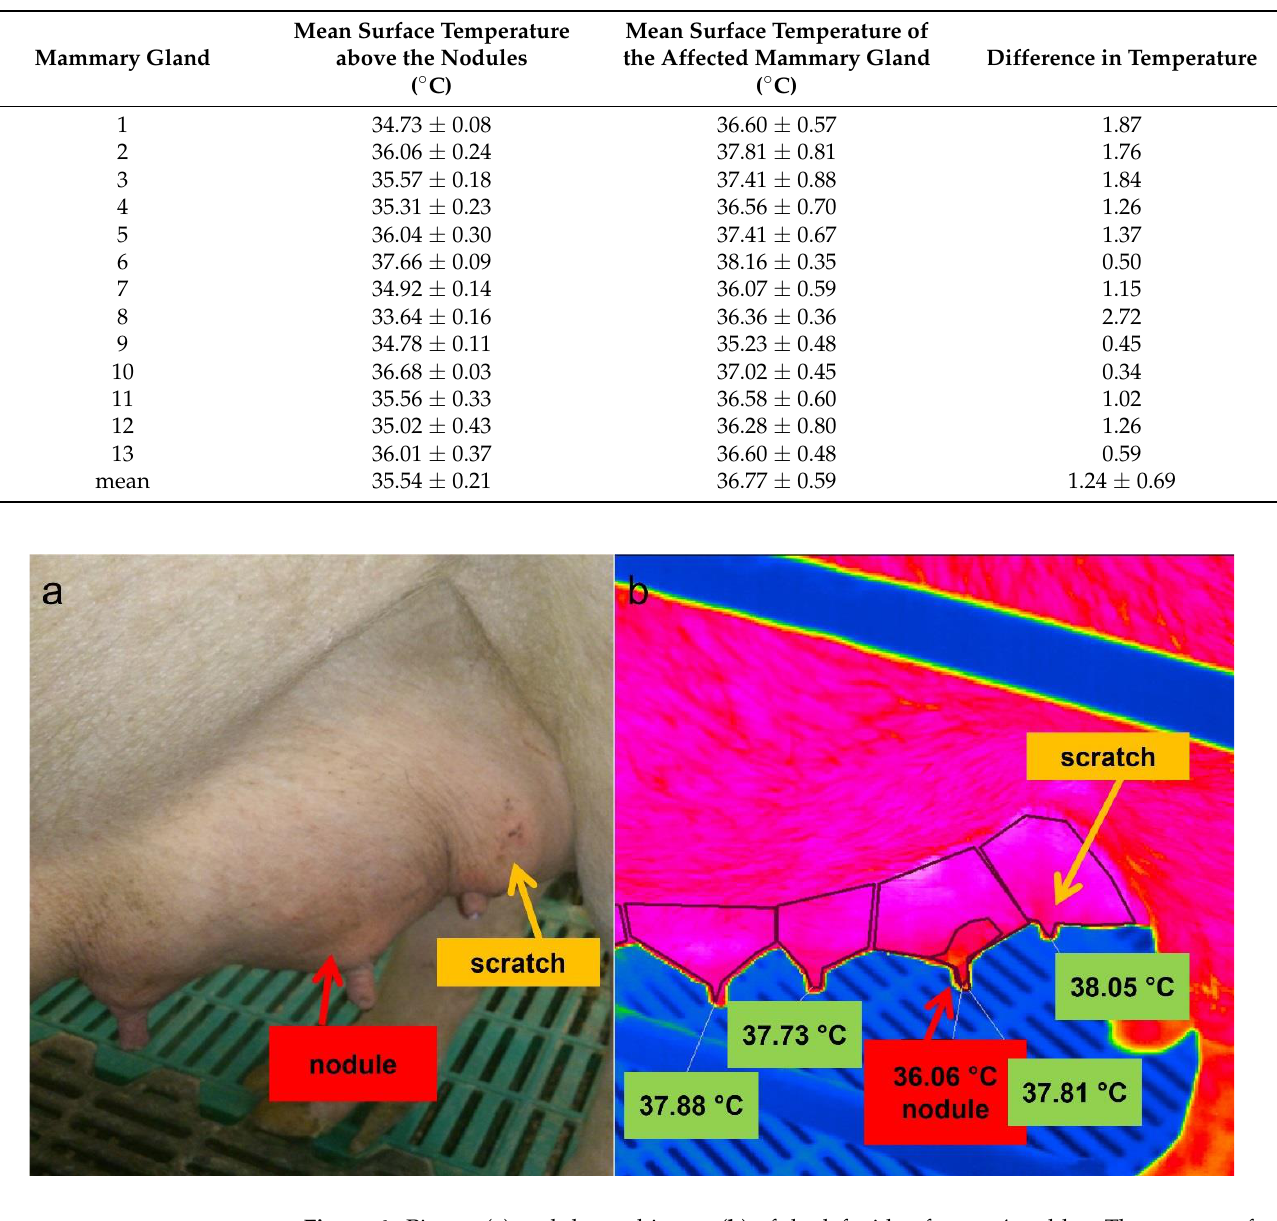
Table 5. Mean surface temperature above the nodules and the total skin area of the affected mammary gland.